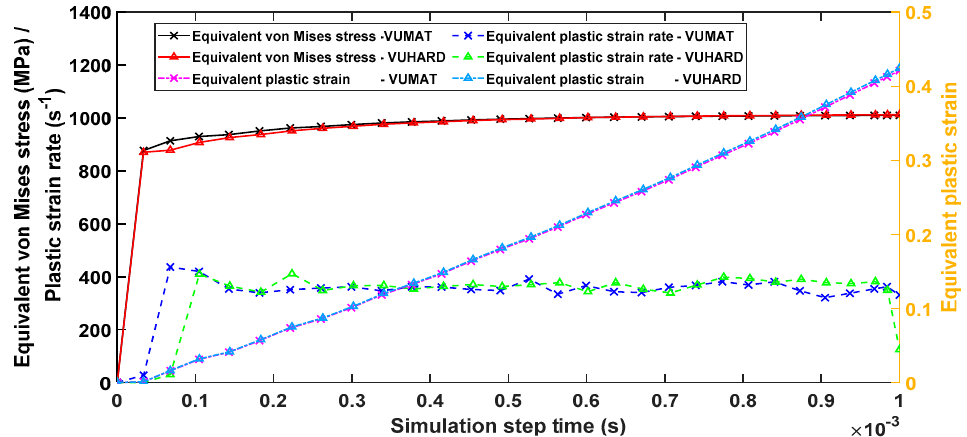
Figure 6. The equivalent von Mises stress, plastic strain, and strain rate against simulation time history generated in VUMAT and VUHARD subroutines developed here for a test velocity of 4 m/s and a temperature of 298 K.